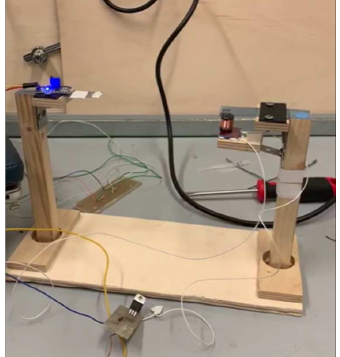
Figure 3. Implementation of demo 1: On the left is the strain gauge, representing the patient station; on the right is the electromagnet representing the artificial body on which the physician uses his probe. The time-scales are in the order of a few seconds.